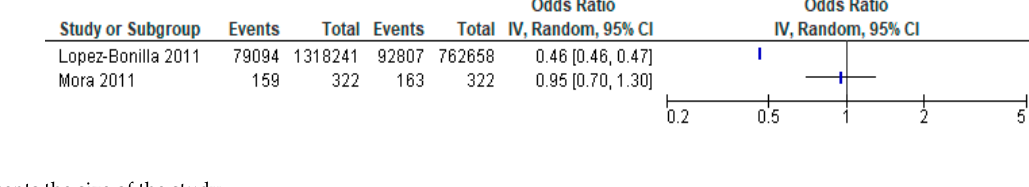
Figure 3. Forest plot assessing fatal occupational injuries in informal economy workers, compared with formal economy workers.